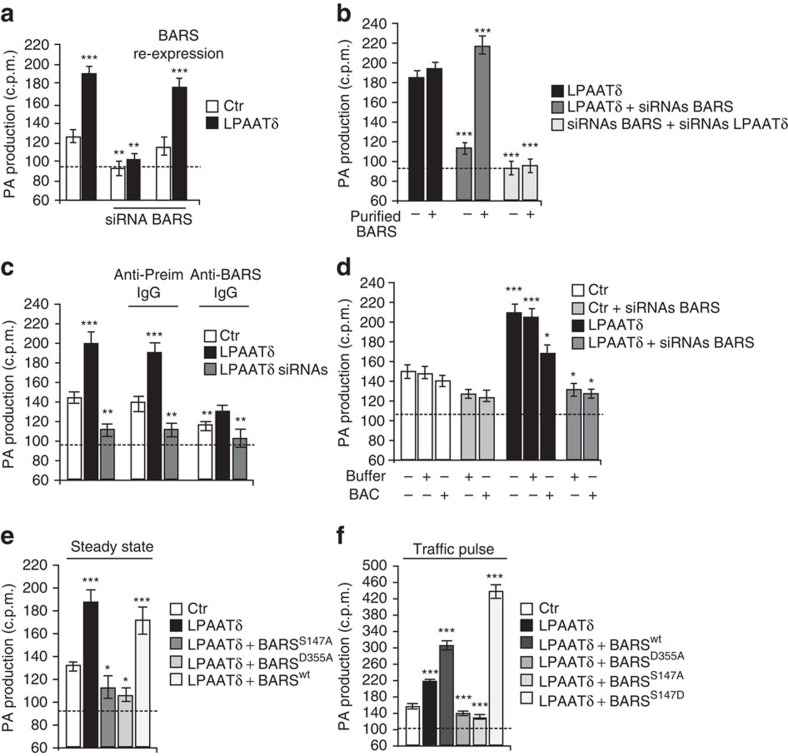
BARS activates LPAATδ and this activation is required for post-Golgi carrier formation.Quantification of phosphatidic acid (PA) production in the LPAAT assay for post-nuclear supernatants from HeLa cells transfected with: (a) empty Flag-vector (Ctr) or LPAATδ–Flag (LPAATδ) and with BARS siRNAs for 48 h, and with the last 12 h with siRNA-resistant replacement BARS–YFP-encoding vector (BARS re-expression); (b) LPAATδ–Flag (LPAATδ) and/or with BARS siRNAs and/or LPAATδ siRNAs. Post-nuclear fractions were incubated with immunopurified BARS (Purified BARS) for 30 min at 25 °C before LPAAT assay (as indicated). (c) Quantification of PA production in the LPAAT assay for post-nuclear supernatants from HeLa cells transfected with empty Flag-vector (Ctr) or LPAATδ–Flag (LPAATδ) for 48 h or with LPAATδ siRNAs for 72 h. The anti-BARS polyclonal antibody (Anti-BARS IgG) or anti-preimmune-IgG (Anti-Preim IgG, as control) was incubated with the indicated post-nuclear fraction for 30 min at 25 °C before LPAAT assay. (d) Quantification of PA production in the LPAAT assay for post-nuclear supernatants from HeLa cells transfected with empty Flag-vector (Ctr) or LPAATδ–Flag (LPAATδ) and with BARS siRNAs for 48 h. Post-nuclear fractions were incubated with HPLC-purified BAC (BAC+) or with buffer alone (Buffer+) for 30 min at 25 °C before LPAAT assay (as indicated). (e,f) Quantification of PA production in the LPAAT assay for post-nuclear supernatants from HeLa cells transfected with: (e) empty Flag-vector (Ctr) or LPAATδ–Flag (LPAATδ) for 48 h and the last 12 h with BARSS147A–YFP, BARSD355A–YFP or BARSwt–YFP (as indicated); (f) empty Flag-vector (Ctr) or LPAATδ–Flag (LPAATδ) for 48 h and the last 12 h with BARSwt–YFP, BARSD355A–YFP, BARSS147A–YFP or BARSS147D–YFP (as indicated). Cells were infected with VSV, subjected to TGN-exit assay and post-nuclear fractionations were prepared 10 min after the shift to 32 °C temperature-release block. The dashed line indicates the level of endogenous LPAAT activity not associated with LPAATδ (see text for details). Data are means±s.d. of three independent experiments. *P<0.05, **P<0.01, ***P<0.005 versus control (Student's t-test). See also Supplementary Fig. 7 for LPAATδ and BARS (wild type and mutants) expression levels in post-nuclear samples.